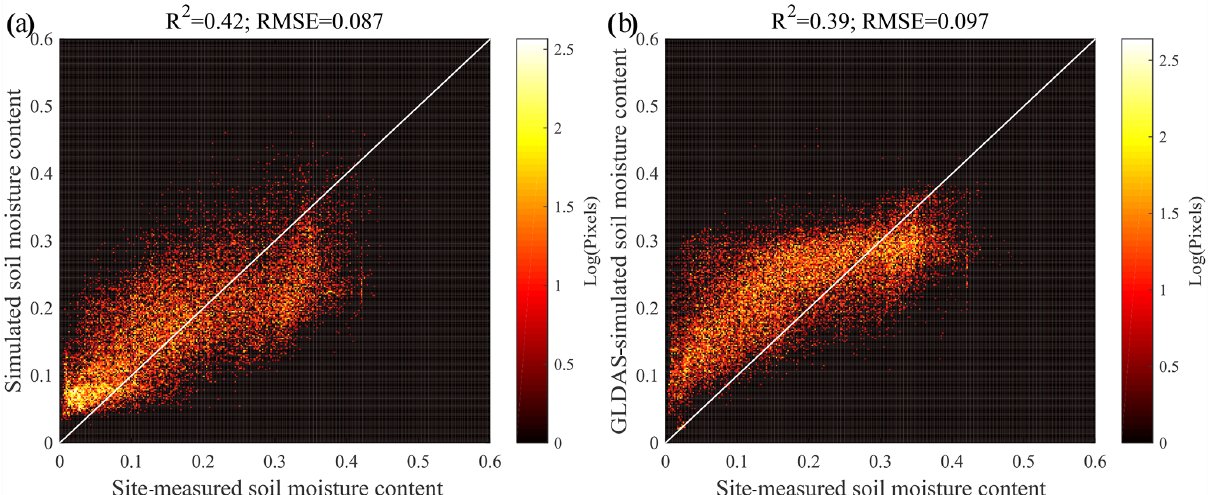
Figure 10. Overall data accuracy comparison between RSSSM and the surface soil moisture simulated by GLDAS Noah V2.1. The scatter- plot is between the (a) RSSSM or (b) GLDAS soil moisture and the measured soil moisture from 2003 to